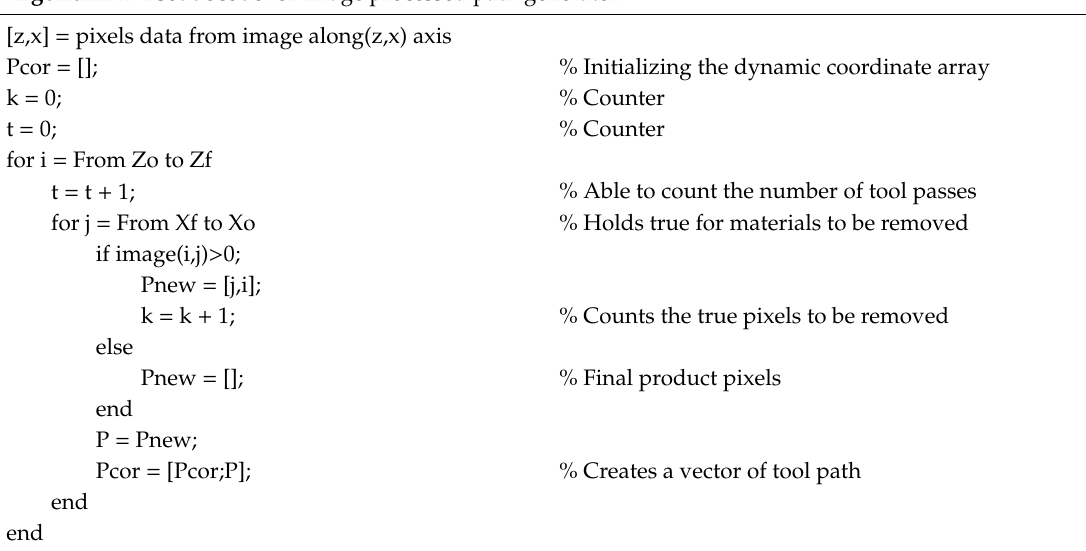
Algorithm 2 : Pseudocode for image processed path